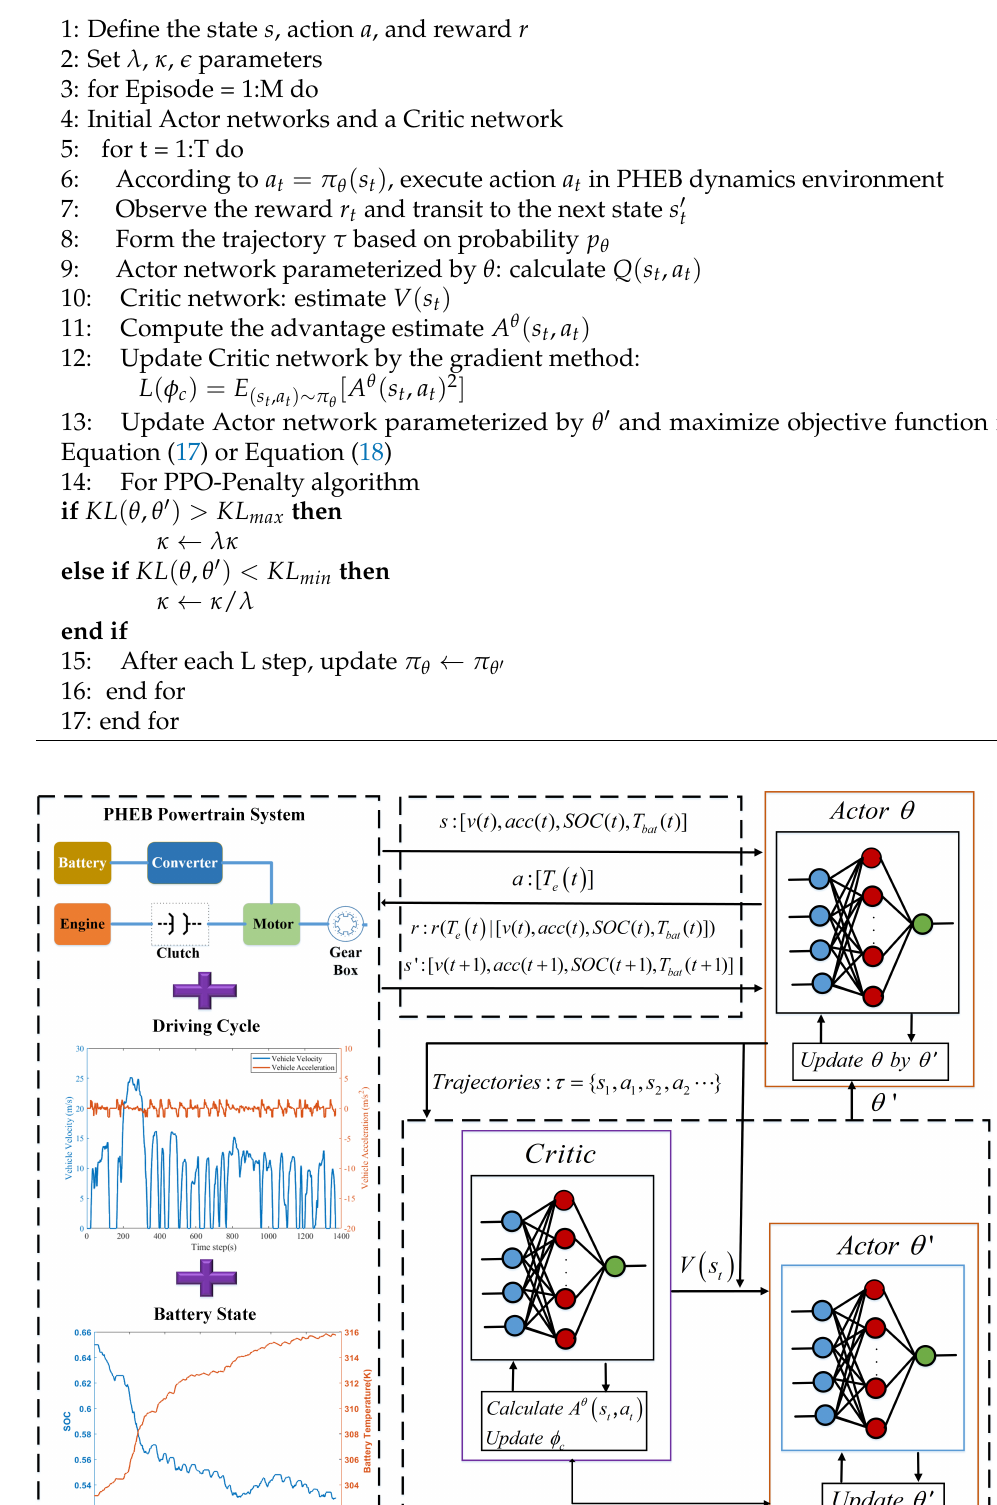
Algorithm 1 PPO-Clip and PPO-Penalty algorithms.